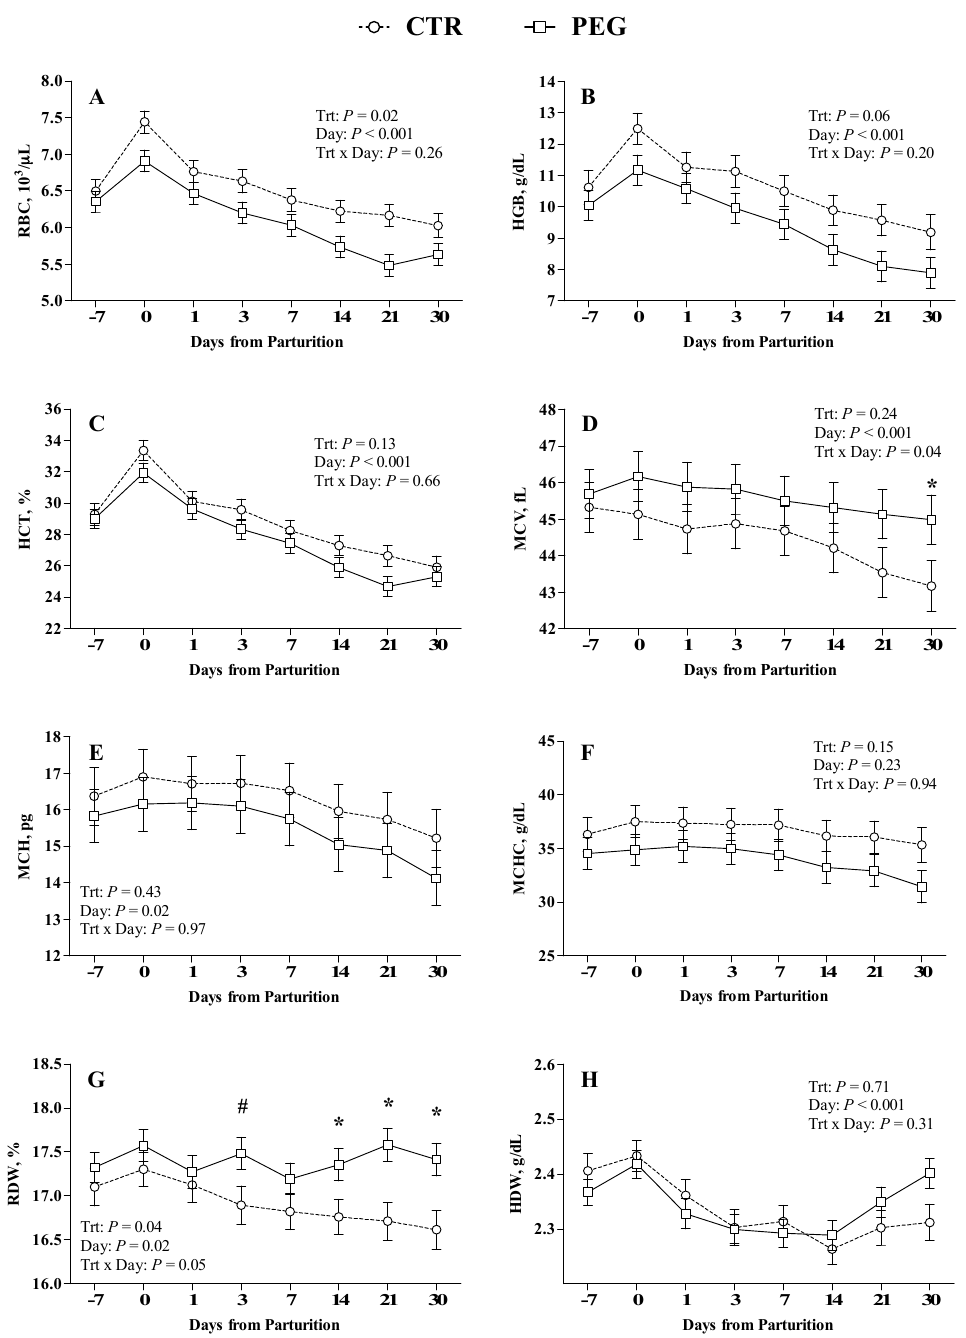
Figure 5. Effect of Pegbovigrastim on red blood cells (RBCs) and their parameters. Least-squares means ± standard error of ( A ) red blood cell count (RBC, × 10 6 / µ L) ( B ) hemoglobin (HGB, g / dL), ( C ) hematocrit (HCT, %), ( D ) mean corpuscular volume (MCV, fL), ( E ) mean corpuscular hemoglobin (MCH, pg), ( F ) mean corpuscular hemoglobin concentration (MCHC, g / dL), ( G ) red cell volume distribution width (RDW, %), and ( H ) hemoglobin concentration distribution width (HDW, g / dL) during the transition period of Simmental. Asterisks (*) indicate differences at p < 0.05, whereas hashtags (#) indicate tendency at 0.10 ≥ p > 0.05.